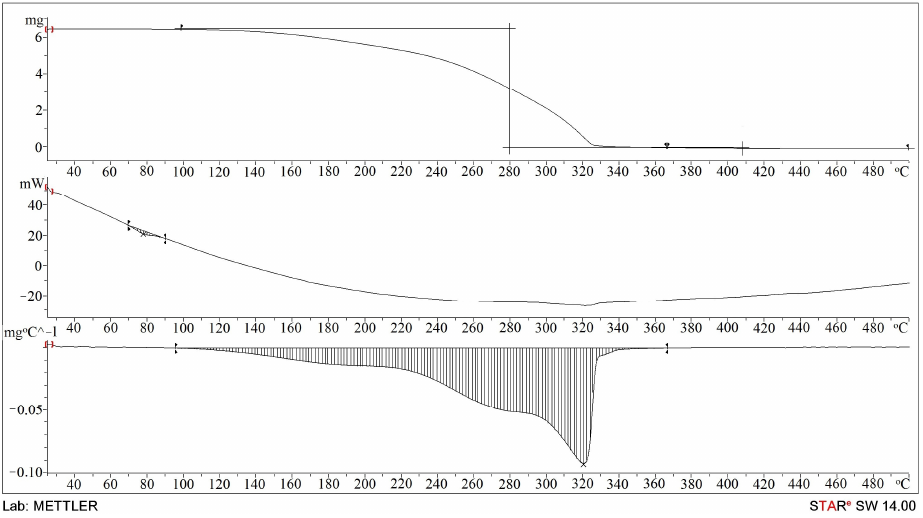
Figure 2. TGA curve of the analysis of the BPEA . Table 3. Results of thermogravimetric analysis of plasticizer .